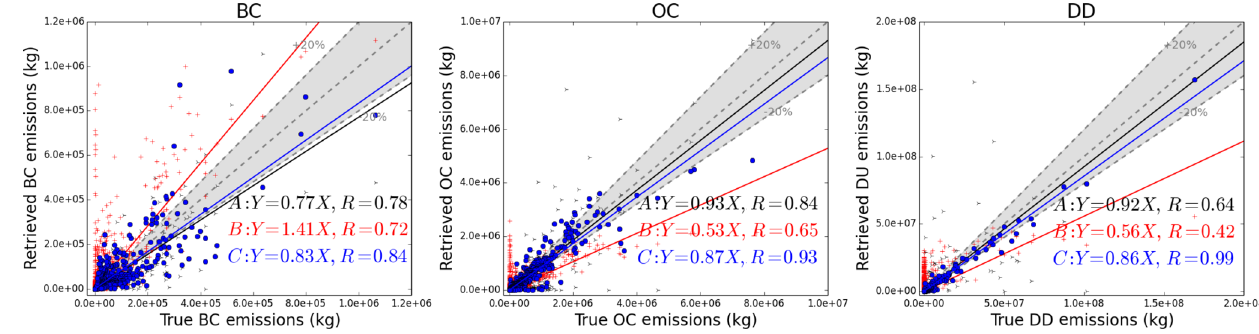
Figure 8. Scatter plots among BC, OC and DD emissions retrieved from Retrievals A, B and C versus true values.